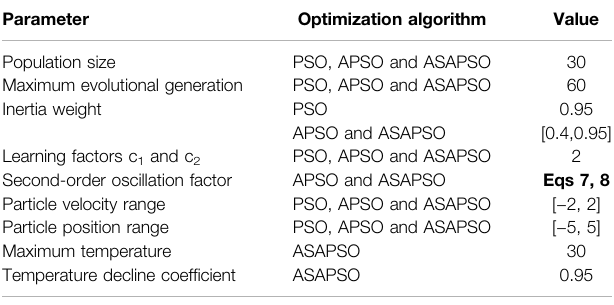
TABLE 2 | Parameter settings of PSO, APSO and ASAPSO.